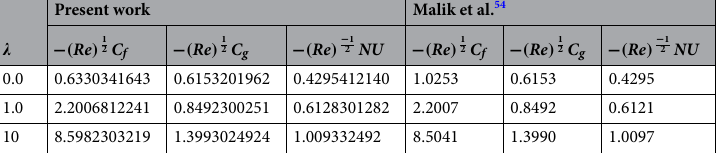
Table 3. Validation in view of numerical behavior for flow rates and temperature gradient when ∅ 1 = ∅ 2 = 0.0, β = 0.0, α = 2.0, β = 0.0, β = 0.2, Pr = 0.7, Ec = 0.0, H e i